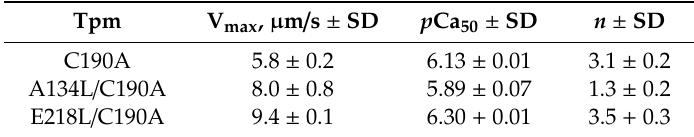
Table 2. Parameters of the Hill equation for the dependence of the sliding velocity of thin filaments containing Tpm mutants in the in vitro motility assay.